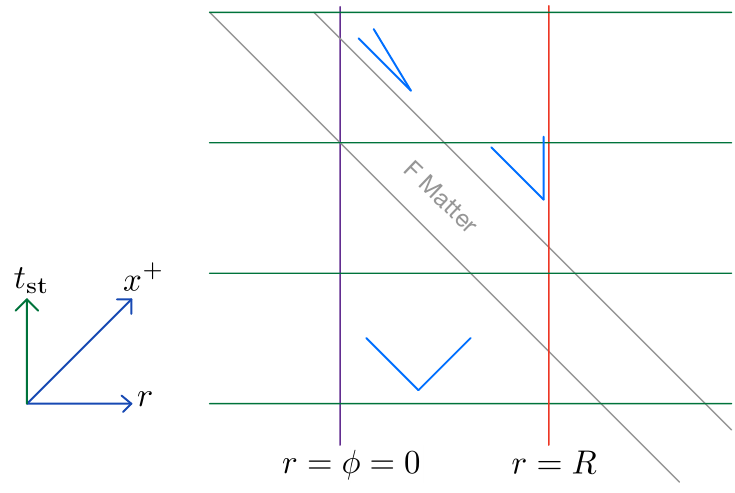
Figure 2 . An Eddington-Finkelstein diagram for the same spacetime as figure 1. Spatial slices are taken to be the “straight” slices described in 5.1.2, with time coordinate denoted t st . The line r = φ = 0 and horizon at r = R are shown, as are representative light cones in light